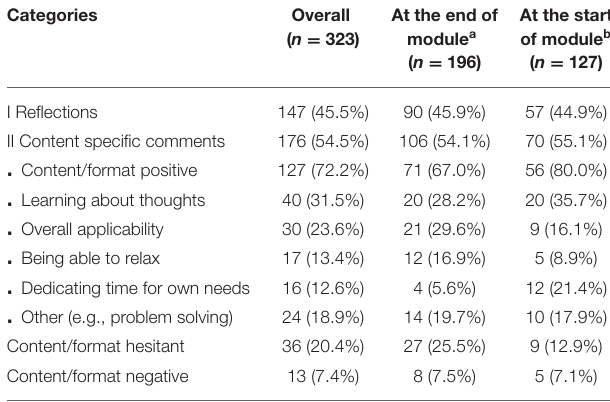
TABLE 3 | Summary of the open-ended module evaluation answers from pilot RCT participants.